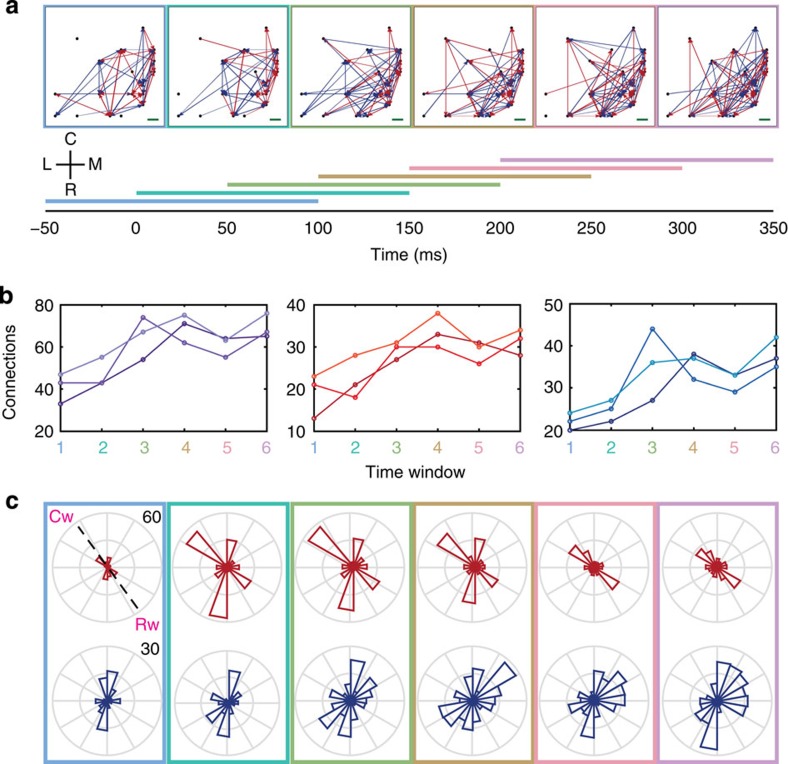
Same as Fig. 3, but for monkey Mk data set. .